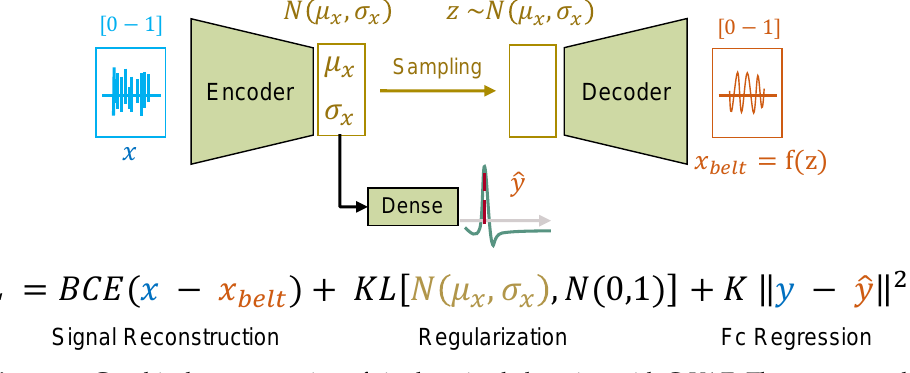
Figure 11. Graphical representation of single-episode learning with C-VAE. The unwrapped radar phase is mapped to the respiration belt signal using the signal reconstruction term. The regularization term makes the latent space closer to a standard multivariate normal distribution. Fc regression allows the parameterization to depend on the respiration